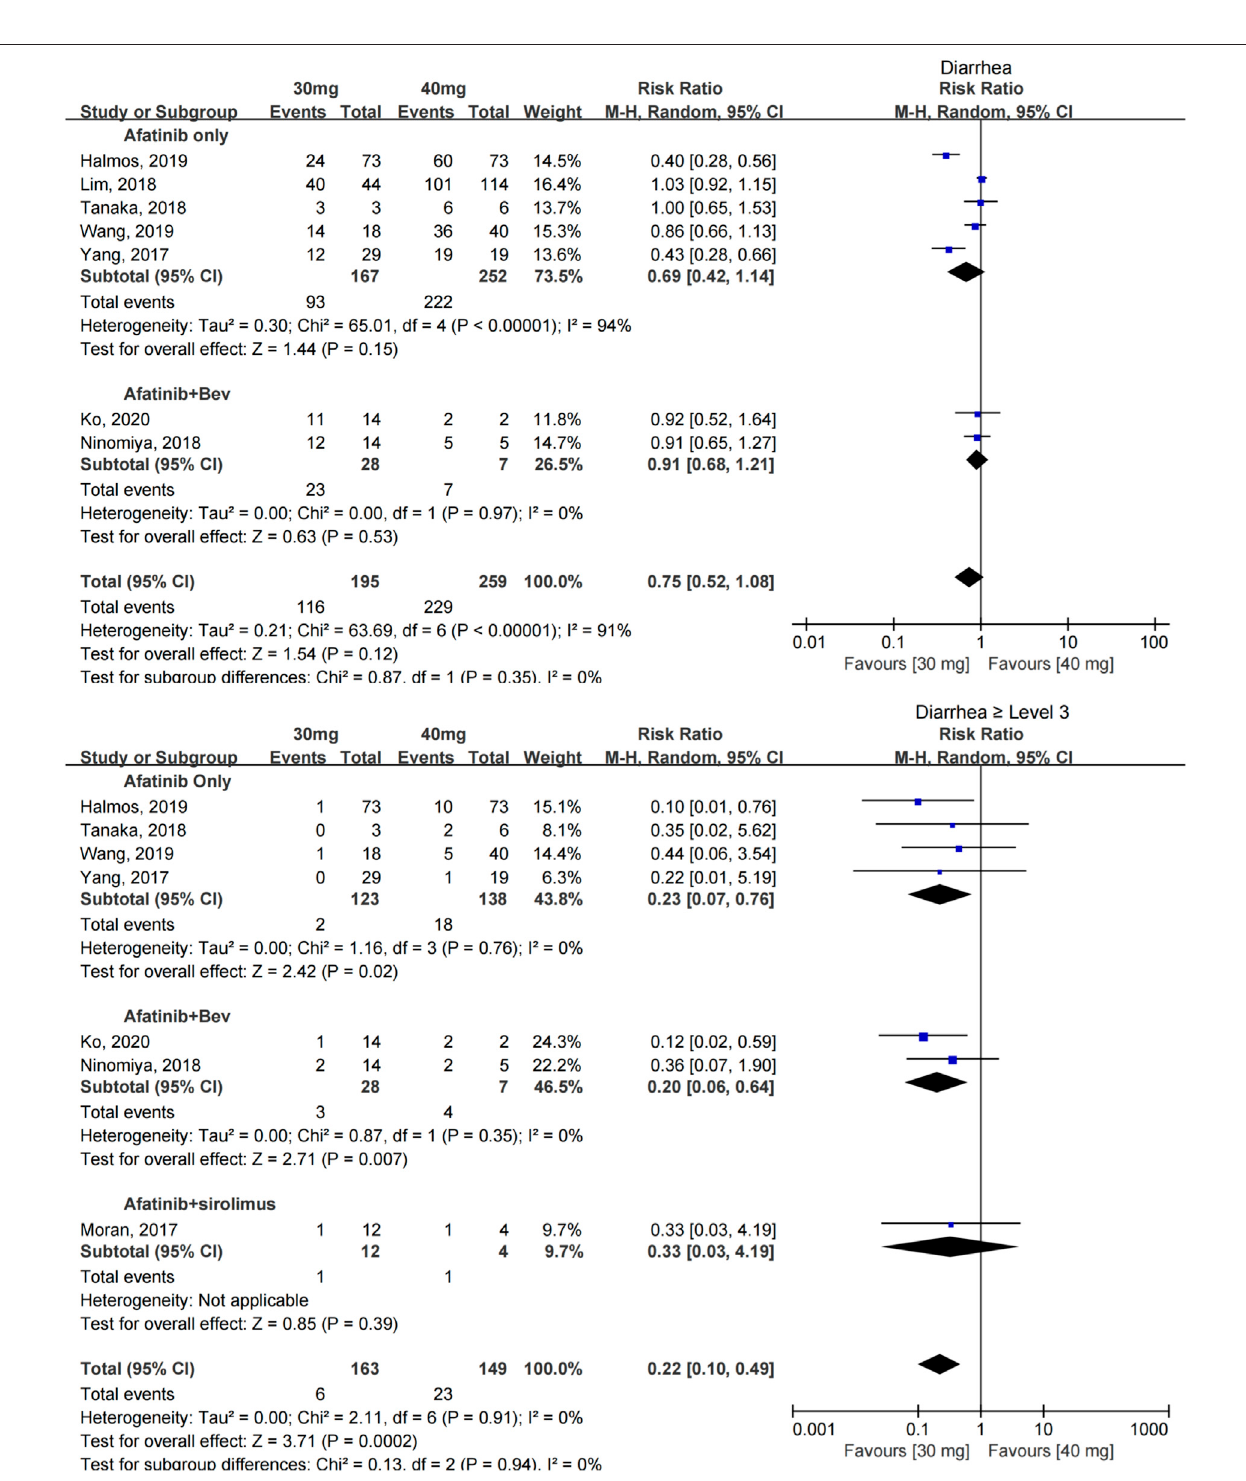
FIGURE 3 | Forest plot of the incidence of diarrhea and ≥ grade 3 diarrhea in the meta-analysis of patients treated with 30 and 40 mg of afatinib.